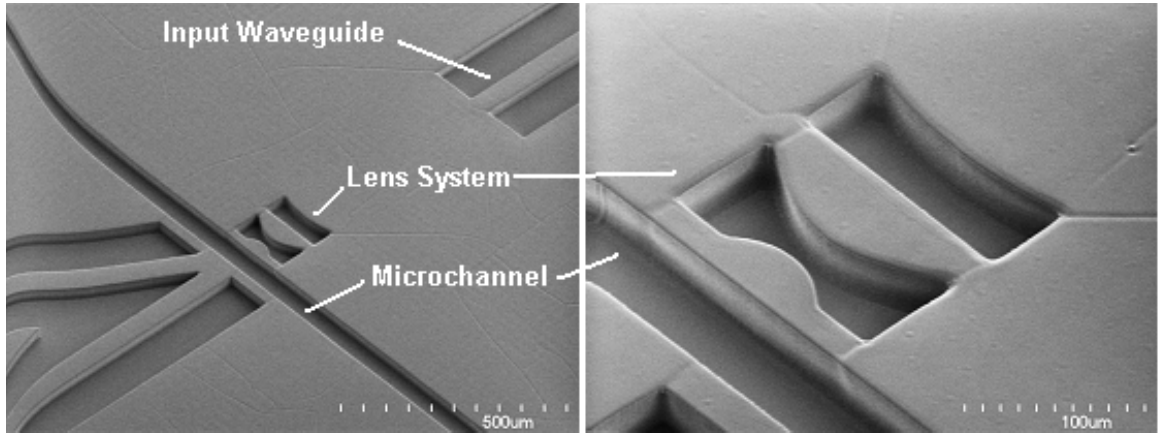
Figure 2. SEM image of the device showing the waveguide core, lens system, and